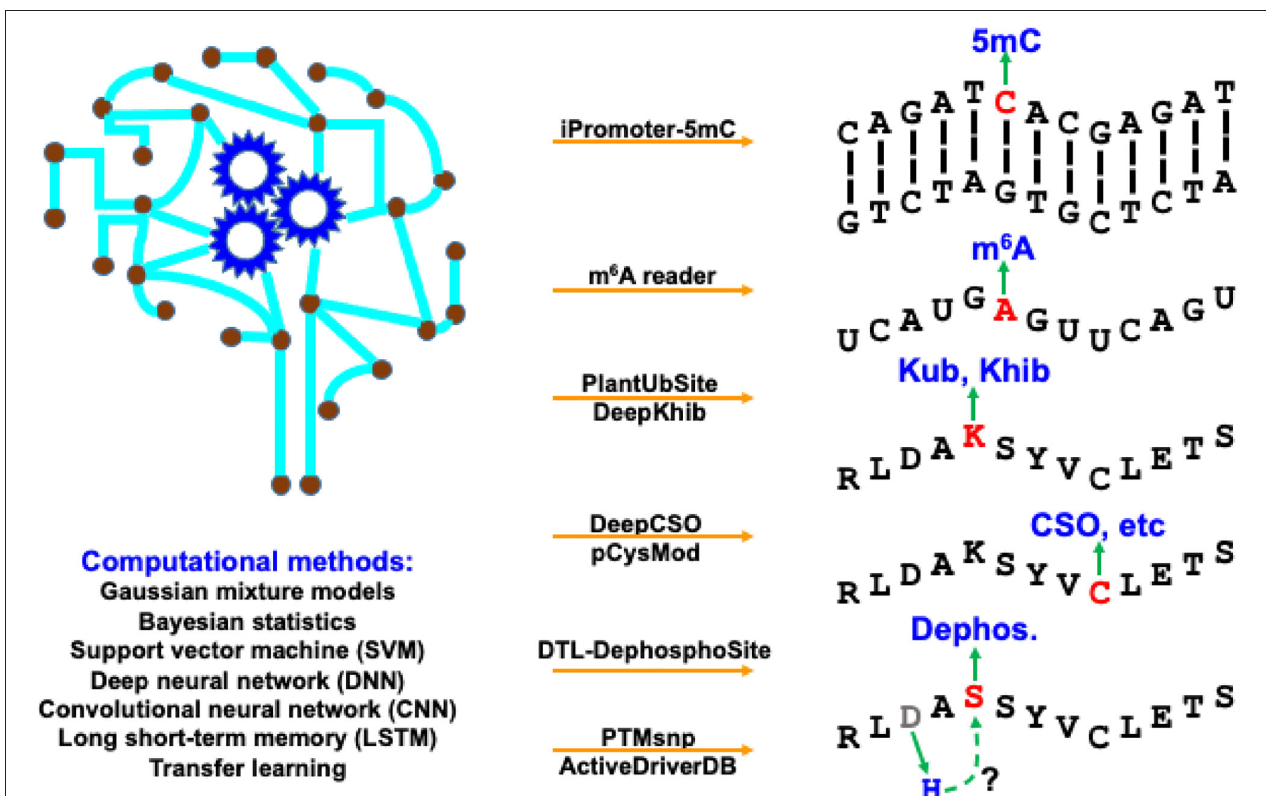
FIGURE 1 | Computational resources covered in this Research Topic, as well as their targeting BCM types and applied